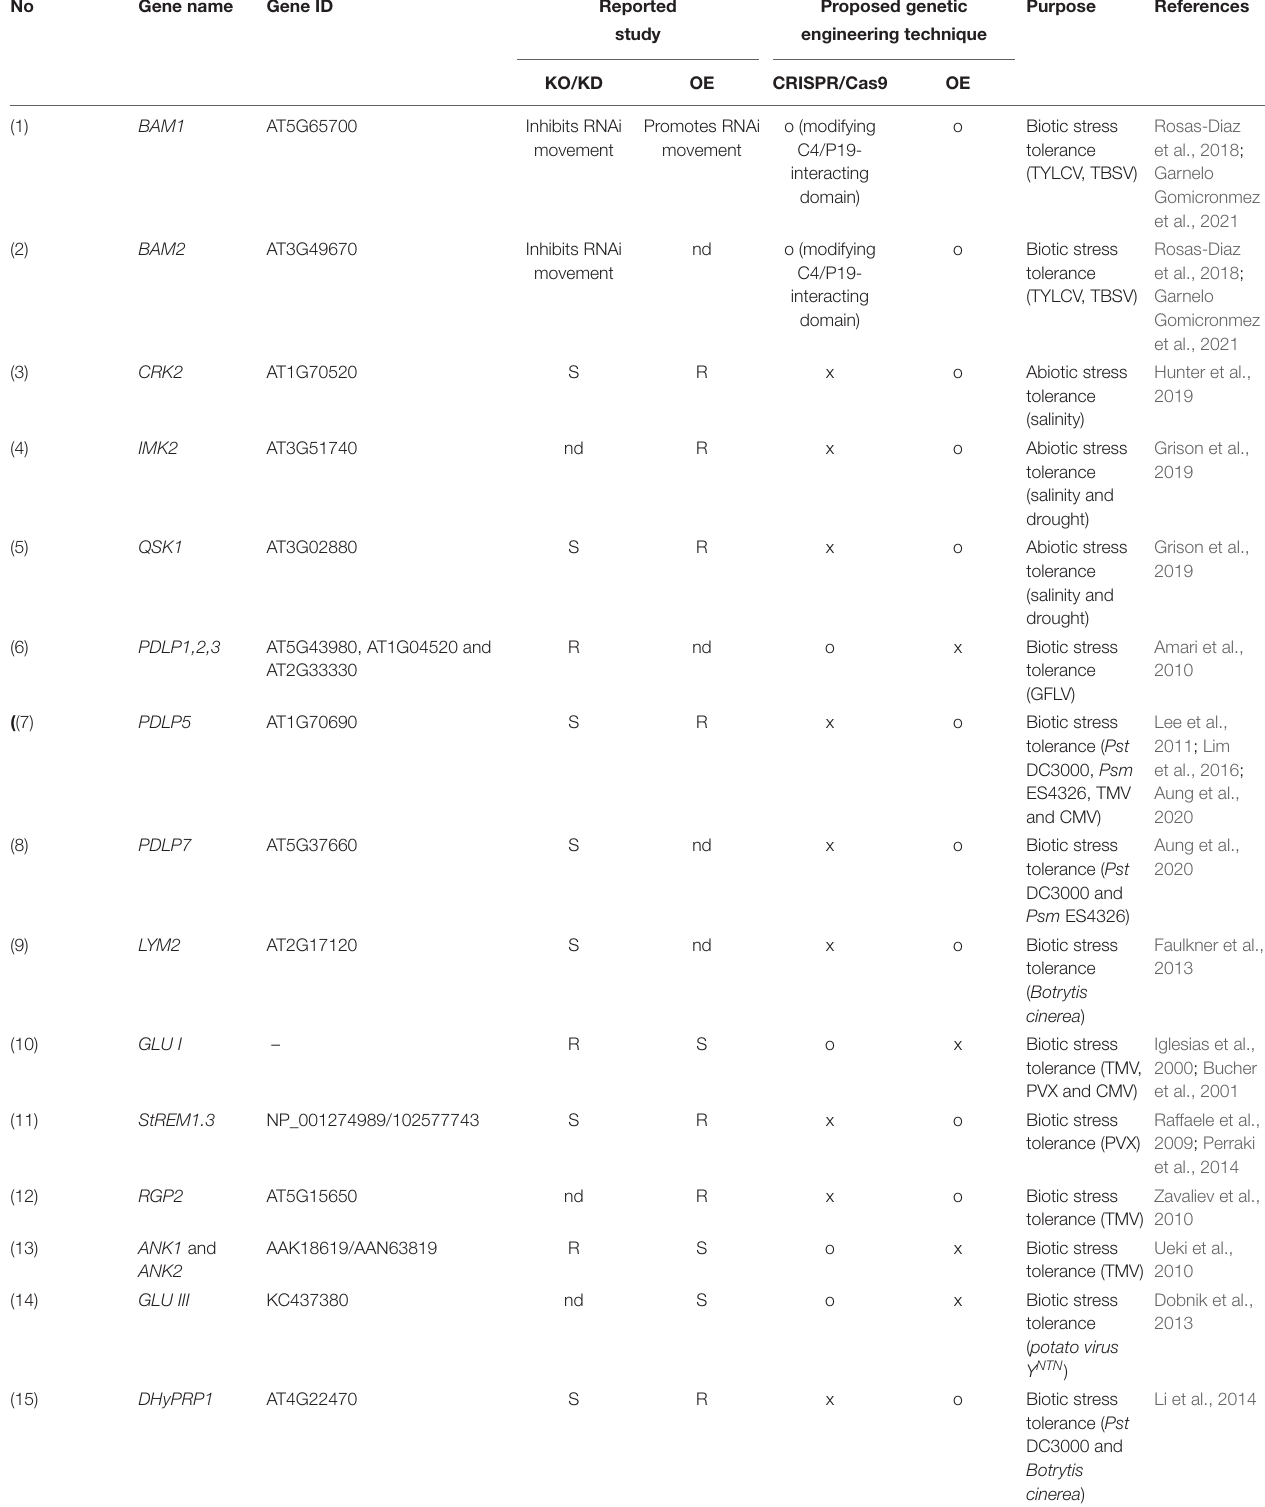
TABLE 4 | Genetic engineering strategies for modulating PD-associated